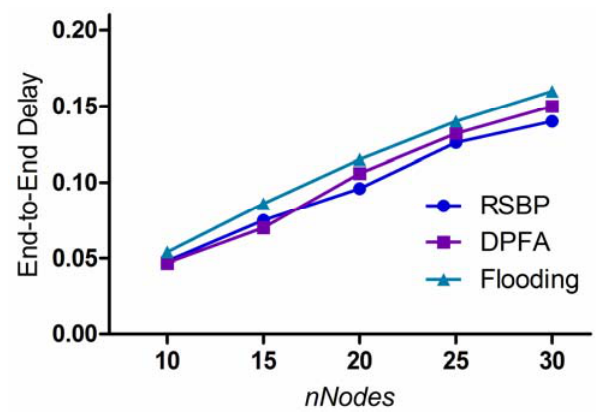
Figure 11. End-to-End